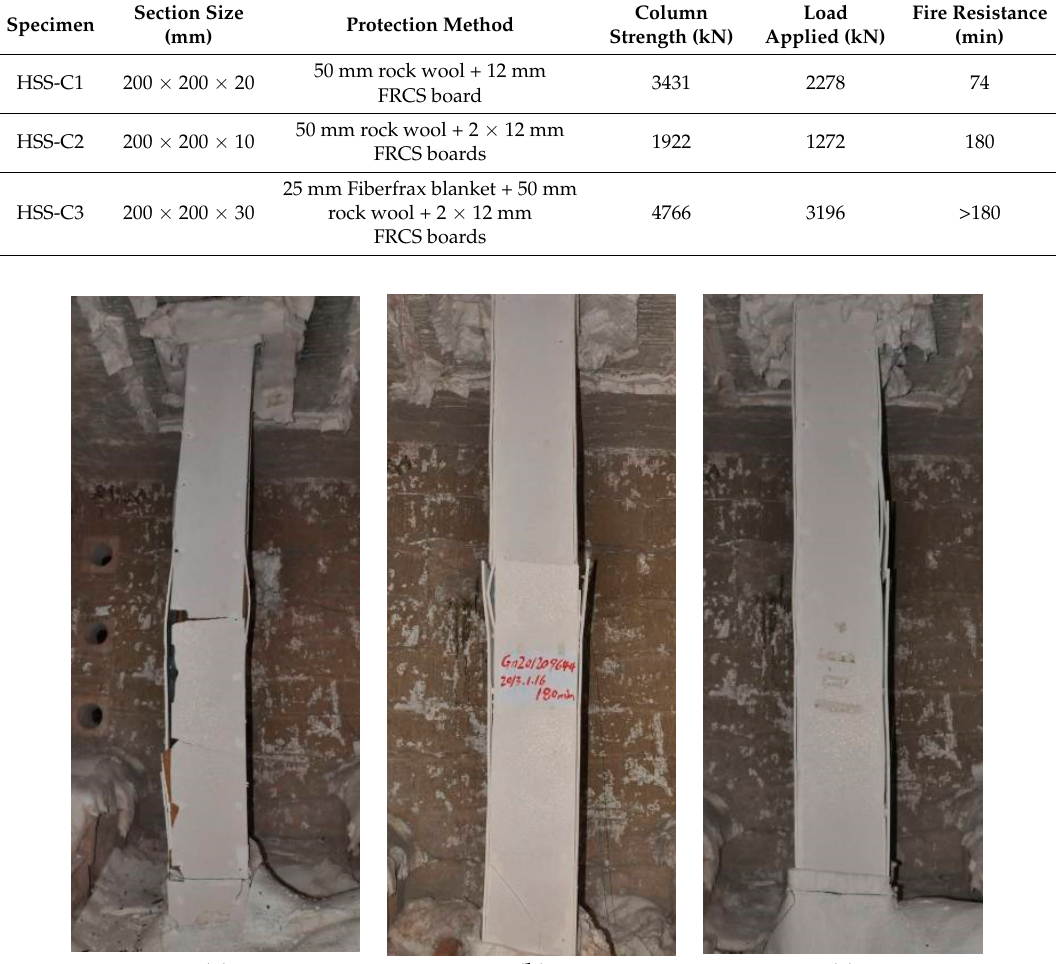
Figure 6. Columns after tests (still in the furnace): ( a ) HSS-C1; ( b ) HSS-C2; ( c ) HSS-C3.